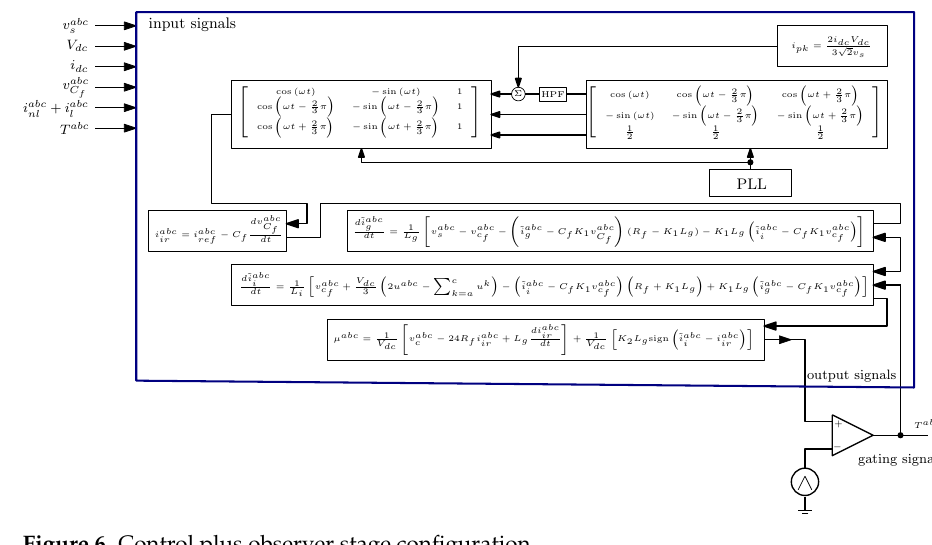
Figure 6. Control plus observer stage